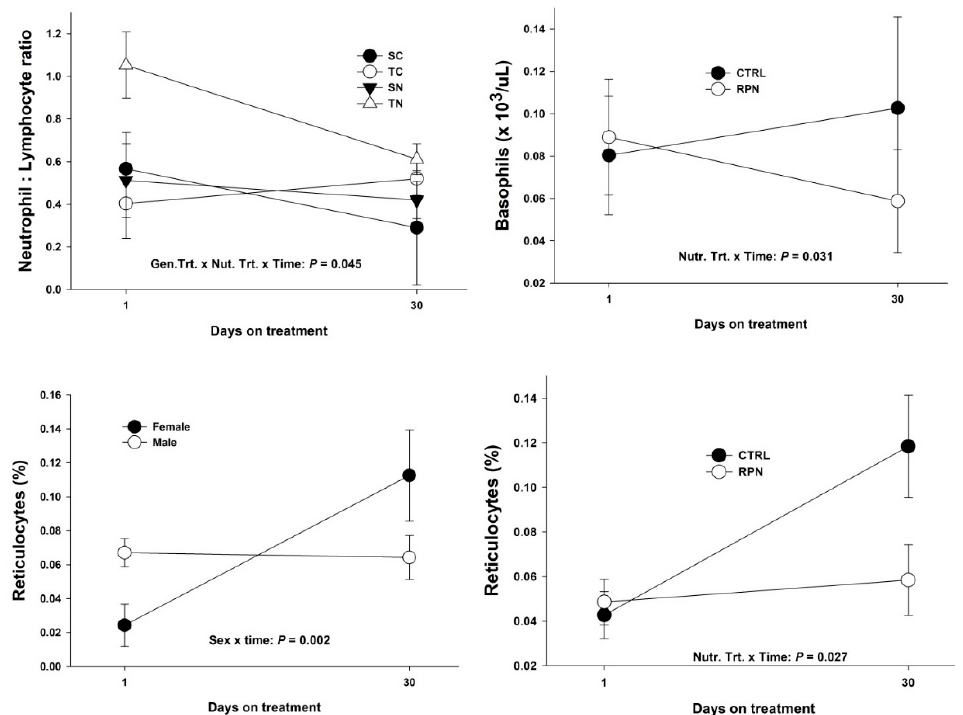
Figure 4. Significant interactions between genetic treatment, nutritional treatment and time for reticulocytes, basophils, and neutrophils to lymphocyte ratio for Angus × Simmental steers and heifers’ offspring. Neutrophil to lymphocyte ratio, basophils (×10 3 /uL) and percentage of reticulocytes results of Angus × Simmental steers (male) and heifers (female) exposed to diets containing rumen-protected niacin (RPN) or without rumen-protected niacin (CTRL), while receiving endophyte-infected tall fescue seeds. Statistically significant differences were declared at p < 0.05 and tendencies at p > 0.05 and <0.1.